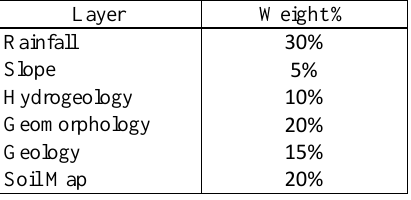
Table 1. Assumed weights of various